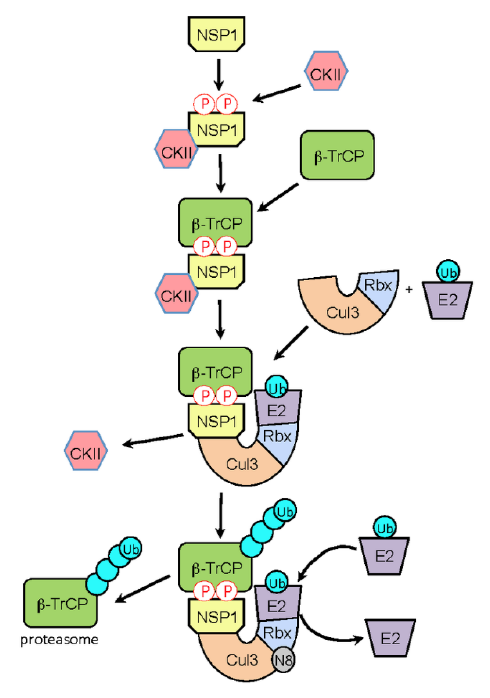
FIGURE 2: Model for NSP1-CRL3 assembly. Following expression in the infected cell, rotavirus NSP1 interacts with the constitutively- active kinase CKII, resulting in phosphorylation of NSP1 C-terminal IκB-like degron. The affinity of β-TrCP for the phosphorylated degron, leads to the formation of an NSP1-β-TrCP-CKII complex. CKII is released as the NSP1-β-TrCP complex interacts with Cul3- Rbx1 to form an NSP1-CRL3. Recruitment of a ubiquitin-charged E2 enzyme to the CRL, followed by neddylation (N8) of the cullin component, facilitates ubiquitination of the β-TrCP target. Succes- sive rounds of ubiquitination generate a polyubiquitin chain that signals proteasomal degradation of